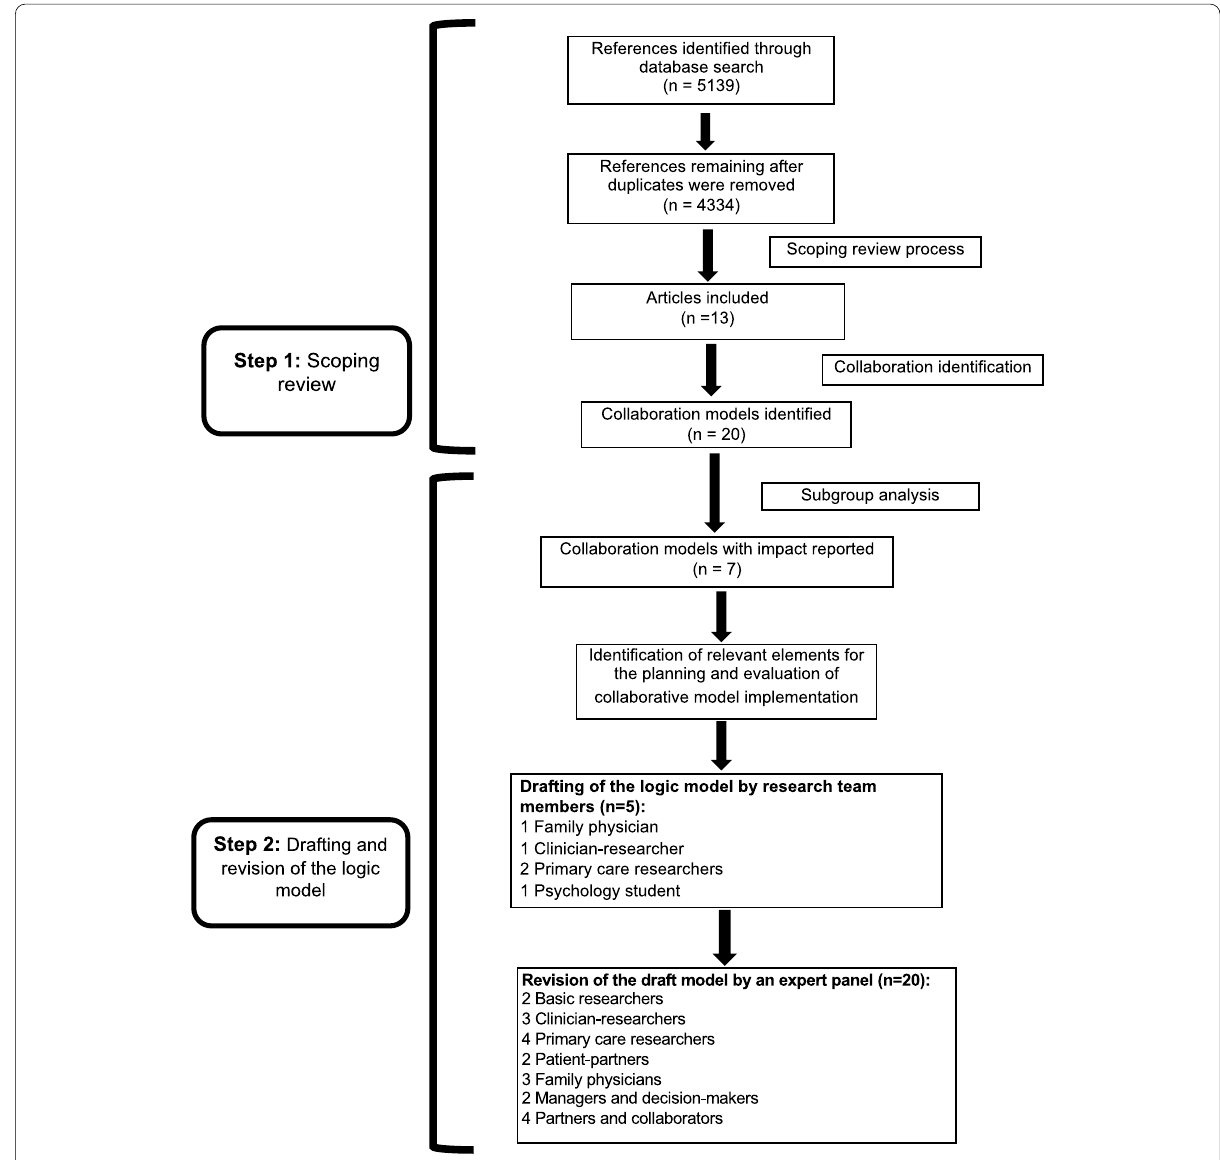
Fig. 1 Methodological approach used to develop the logic